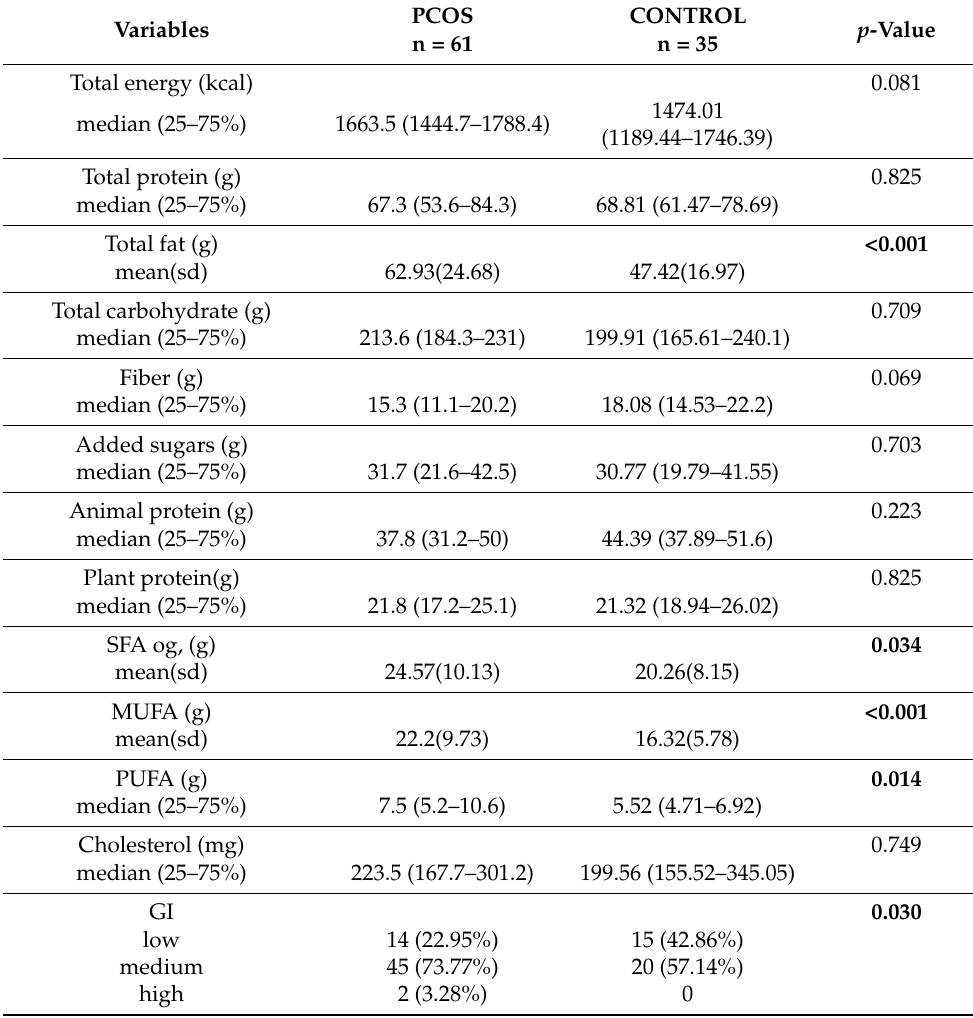
Table 2. Diet composition and physical activity comparison between PCOS group (PCOS) and control group